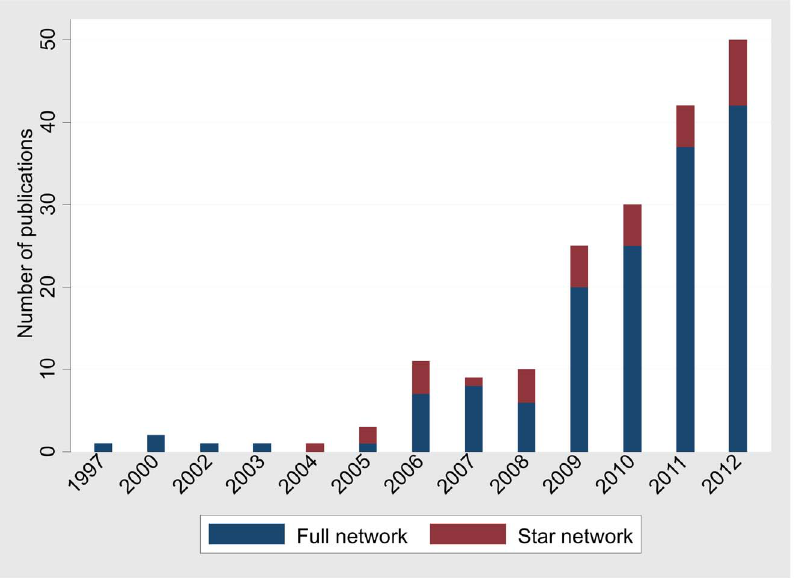
Figure 2. Number of meta-analysis articles with full and star networks published between 1997–2012.